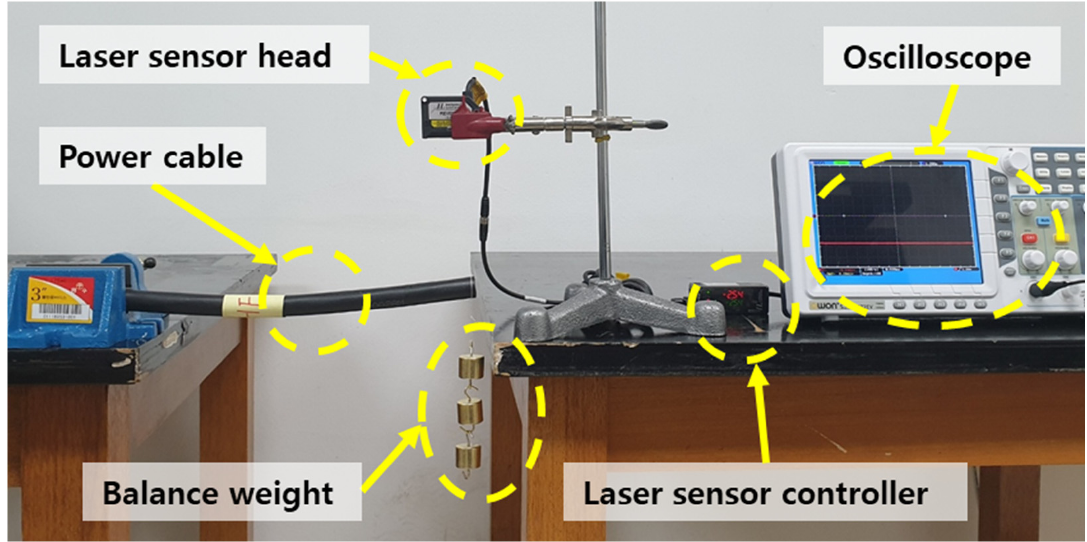
Figure 6. Experimental setup for measurement of flexural rigidity of power cable.